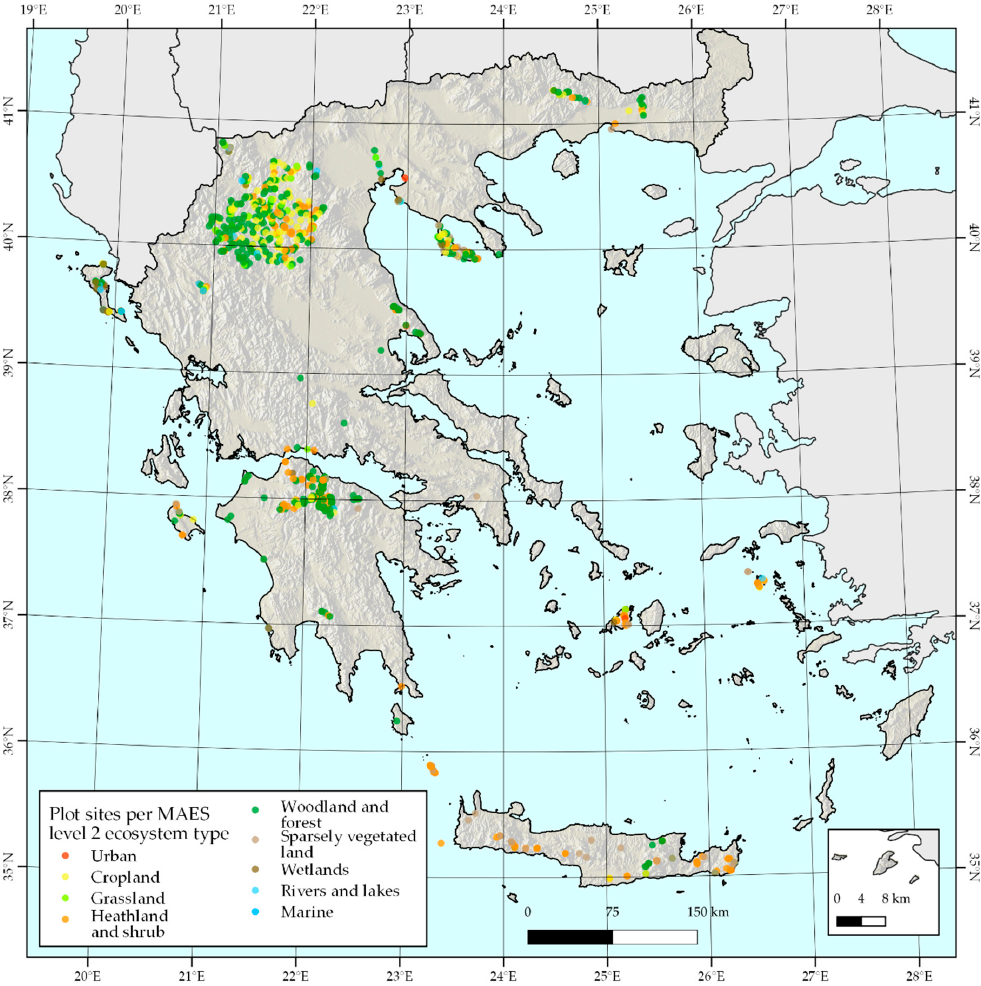
Figure 3. Field-survey plots per MAES level 2 ecosystem type.